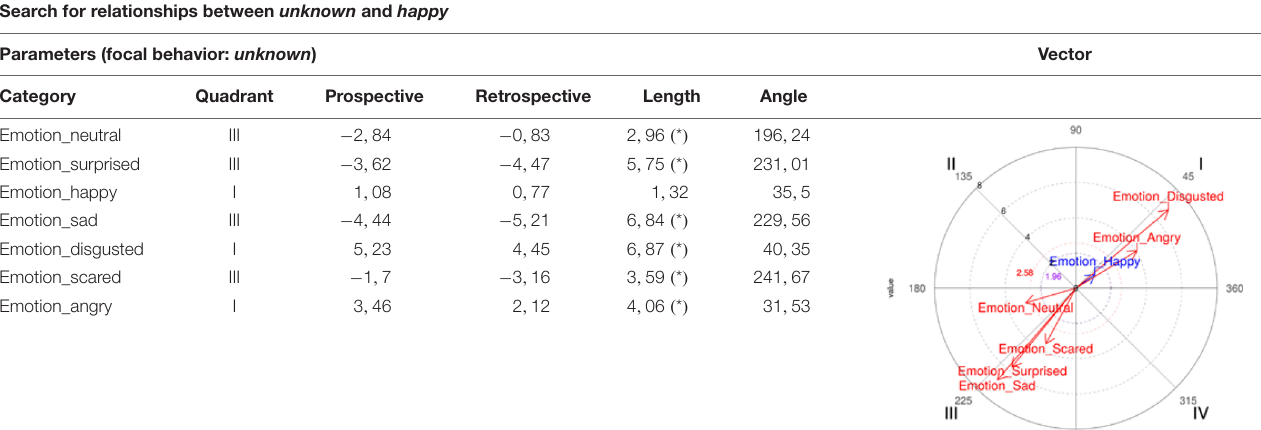
TABLE 3 | Polar coordinate analysis centered on unknown / happy and happy / unknown , corresponding to the girls’ records. Search for relationships between unknown and happy Parameters (focal behavior: unknown